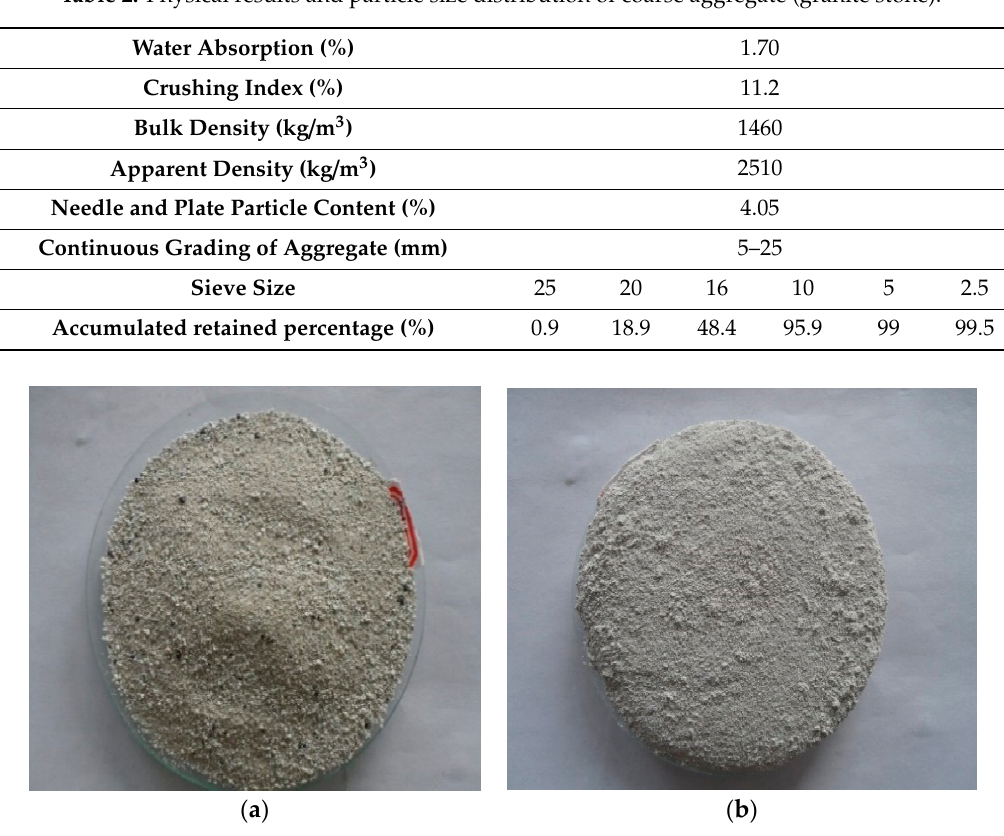
Figure 3. Petroleum coke residue in this study: ( a ) before grinding; ( b ) after grinding.